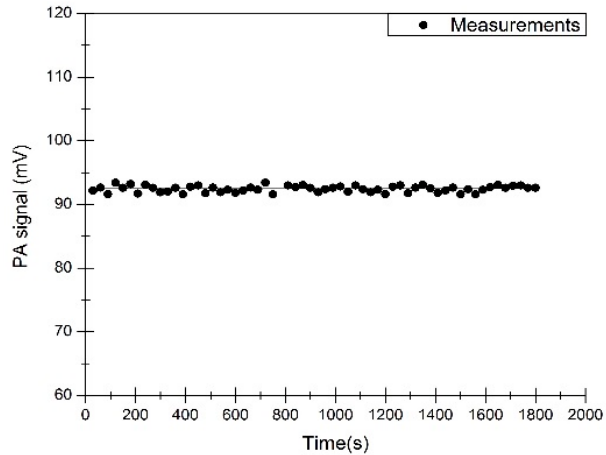
Figure 10. Continuous measurements of 2000 ppm CH 4 .